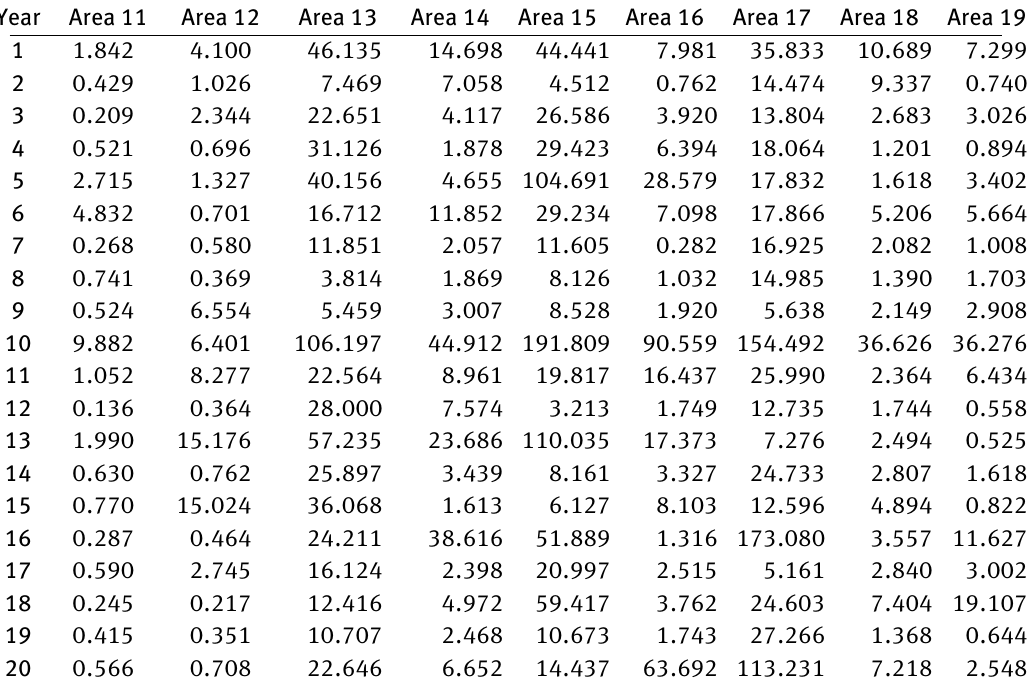
Table 3: Loss data, part II